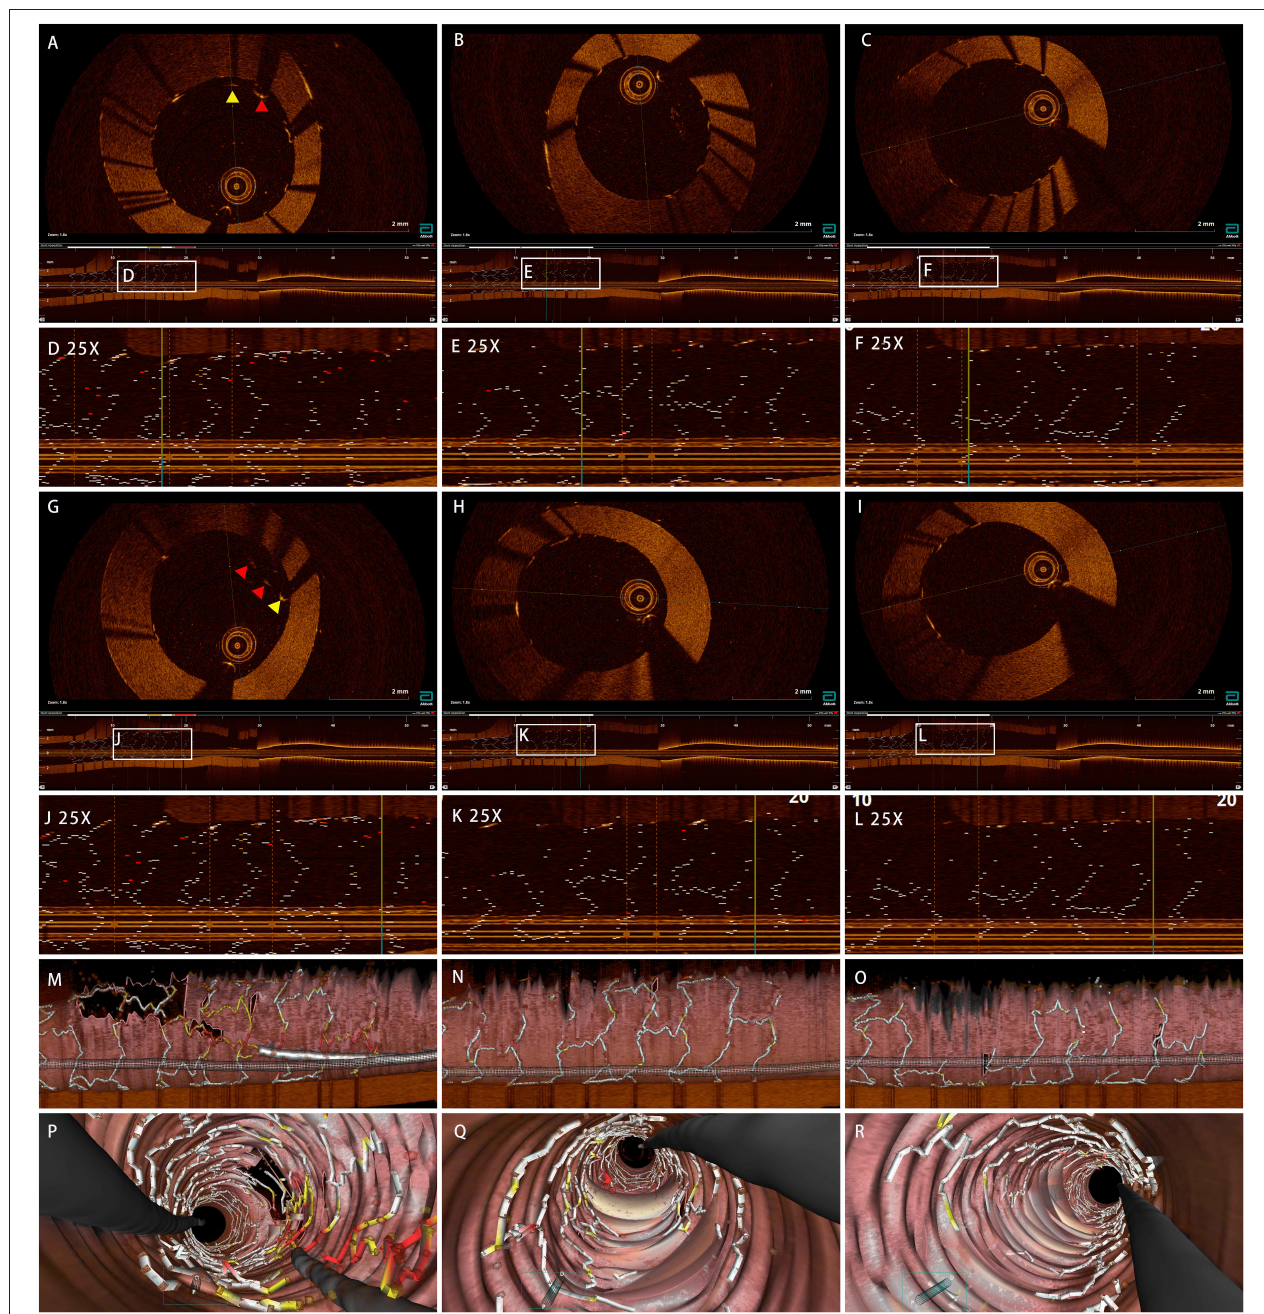
FIGURE 5 | Effect of JB-POT procedures on stent deployment examined by OCT. (A,G) Cross-sections of JB-POT run before jailed wire retrieved. (B,H) Cross-sections of JB-POT final run. (C,I) Cross-sections of self-control run. (D,J) Longitudes of JB-POT run before jailed wire retrieved. (E,K) Longitudes of JB-POT final run. (F,L) Longitudes of self-control run. (M,P) 3D images of JB-POT run before jailed wire retrieved. (N,Q) 3D Images of JB-POT final run. (O,R) 3D Images of self-control run. Red arrows, malapposition distance ≥ 300 µ m; yellow arrows, 200 µ m ≤ Malapposition distance < 300 µ m. JB-POT, jailed balloon proximal optimization technique; OCT, optical coherence